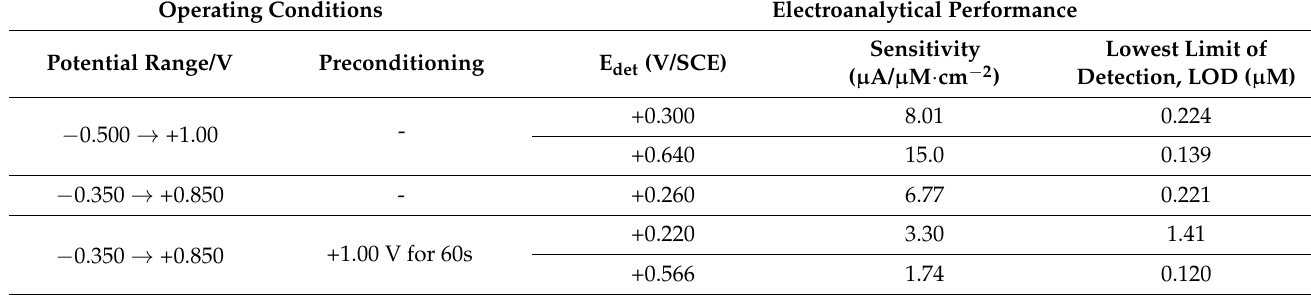
Table 3. The electroanalytical parameters obtained using differential-pulsed voltammetry (DPV) at a MA of 100 mV and the SP of 10